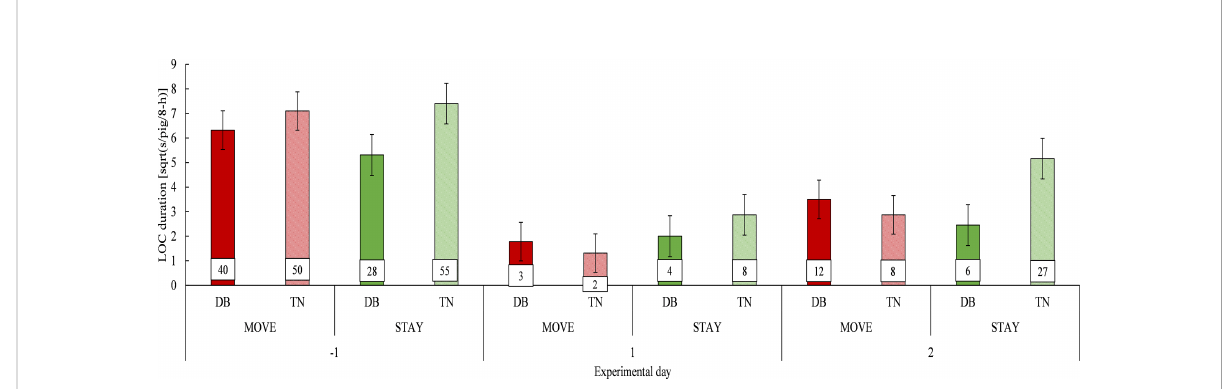
FIGURE 3 Time spent performing locomotor-rotational play (LOC), in s/pig/8-h, in pigs moved to a weaner pen (MOVE; red bars) or kept in the farrowing pen (STAY; green bars) and DanBred pigs (DB; solid bars) or Topigs Norsvin TN70 pigs (TN; striped bars) between 14:00 h and 22:00 h on days − 1, 1, and 2 relative to weaning. The bars represent least squares means and the error bars indicate standard error. Estimates and standard error bars were square root transformed prior to analysis, and the back-transformed least squares means are shown within a box on the top of each bar.